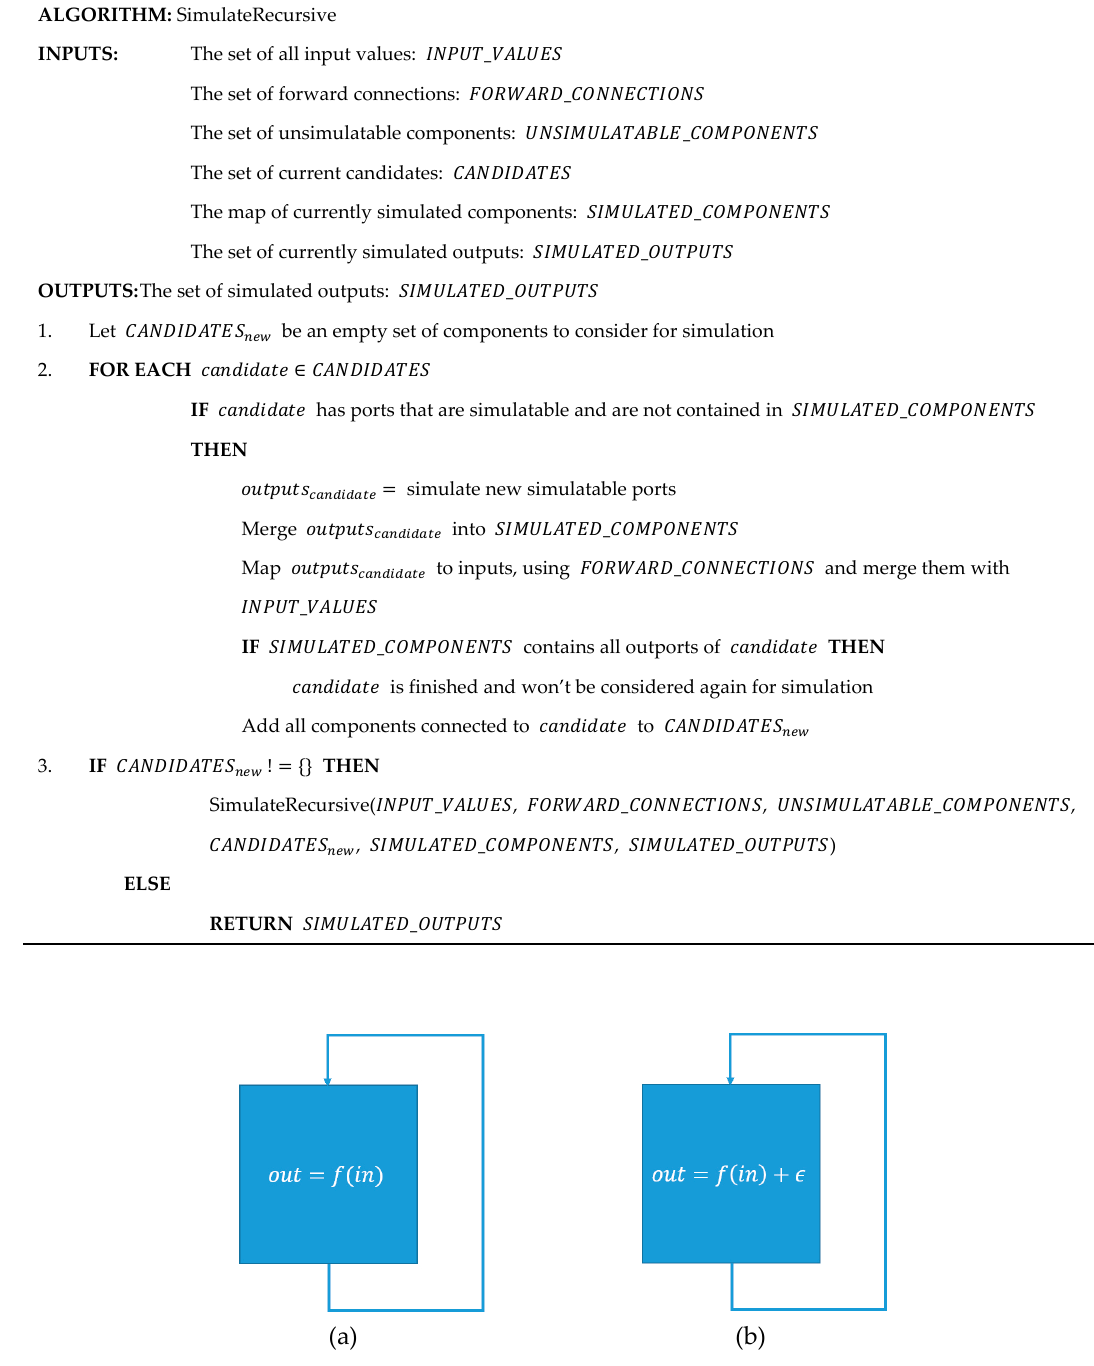
Figure 11. The behavior of a real technical system ( a ) and its model with modelling error ( b ).